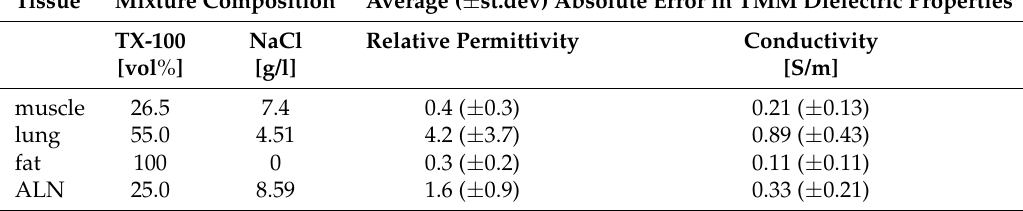
Table 3. Liquid tissue mimicking material mixture recipe. Muscle, fat, lung, and axillary lymph node liquid TMM are made of a liquid mixture of TX-100 and salted water. The first column of the table reports, for each liquid TMM, the percentage volume of TX-100 and the concentration of NaCl in deionized water. The second column of the table reports the average ( ± standard deviation) absolute error, in terms of permittivity and conductivity, computed for each TMM properties with the respect to the corresponding target